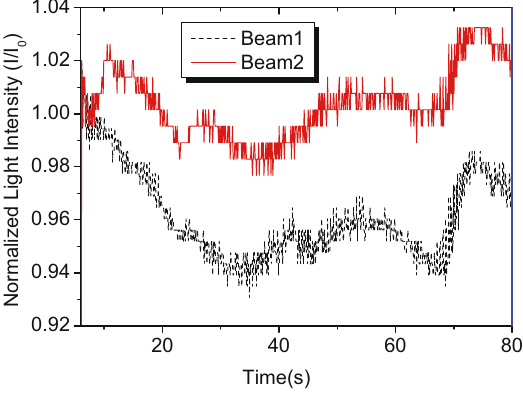
Figure 6: TBC signal of pure polymer P2 at zero electric fi